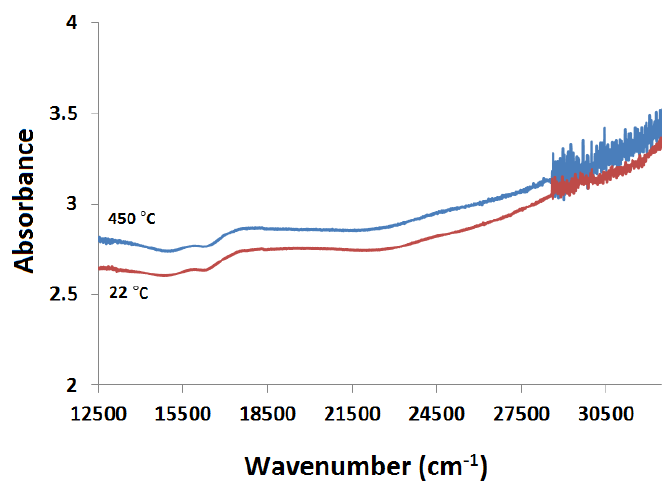
Figure 8. Absorbance scans of a fully oxidized 1La sample obtained at 22 °C and 450 °C. Higher temperatures cause the absorbance signal to increase.